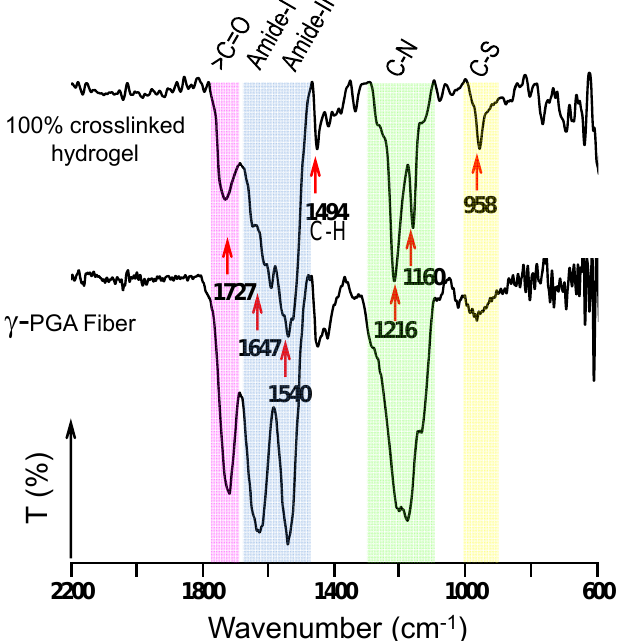
Figure 5. FTIR spectra of a theoretically 100% crosslinked hydrogel obtained from electrospun nanofibers. For comparison, the spectrum of electrospun γ -PGA nanofibers taken before the crosslink- ing process is also provided. Note that the 100% crosslinking reaction was not complete (see text for further details).